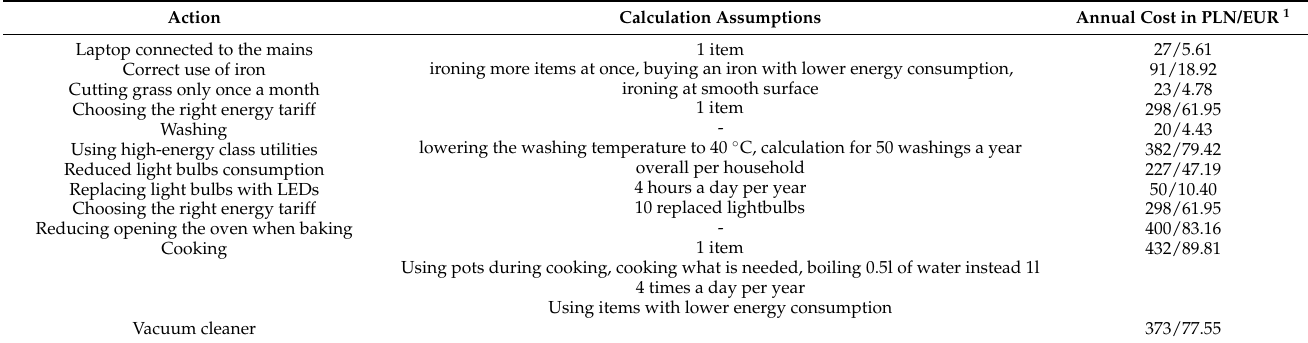
Table 4. Annual costs of energy used by utilities in households (in PLN and